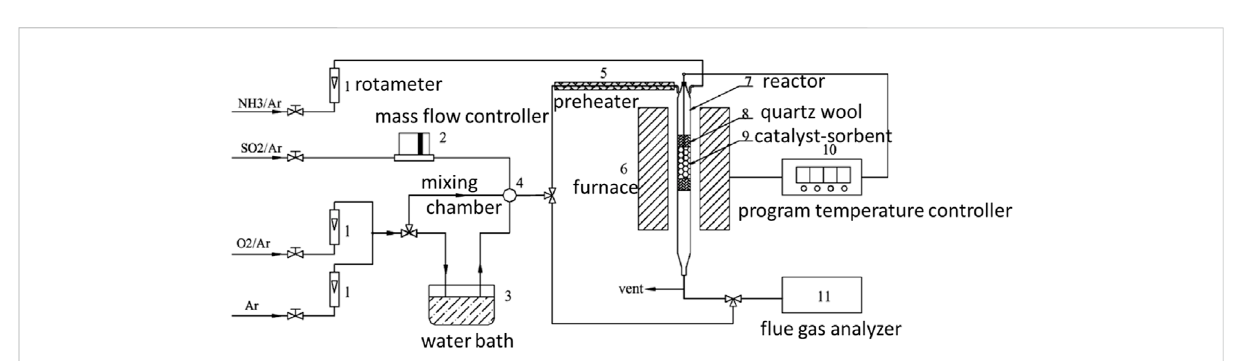
FIGURE 10 Schematic diagram of the desulfurization regeneration experimental device (Xie et al.,